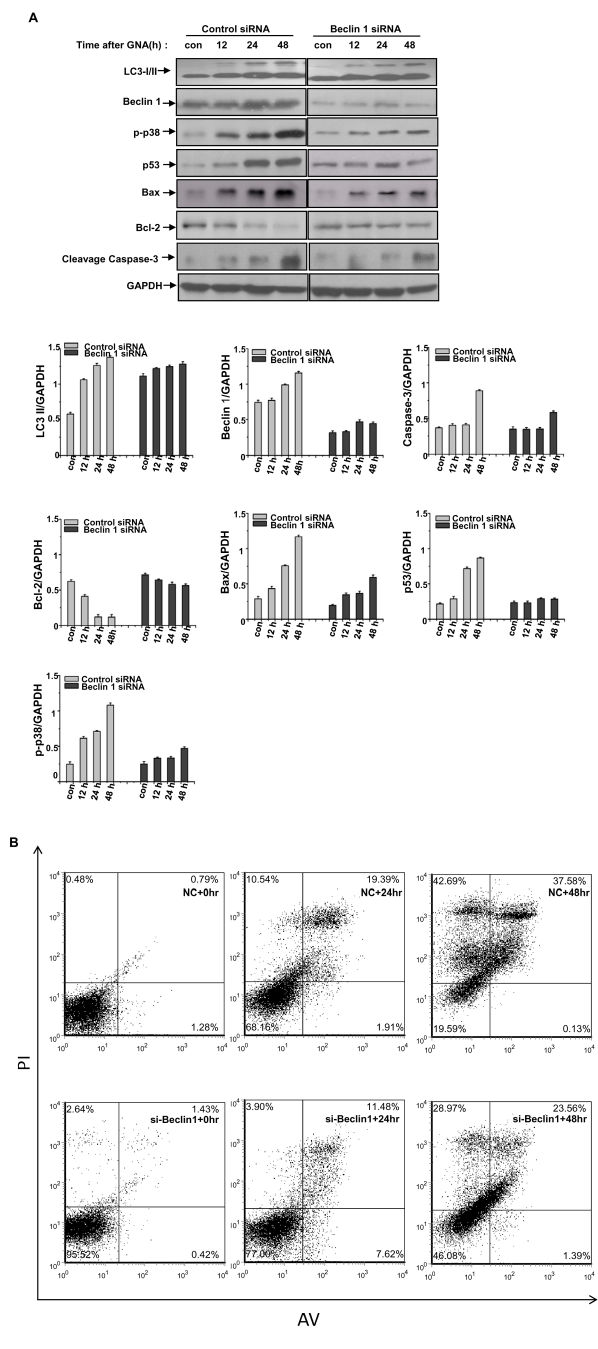
Figure 6. GNA induces apoptosis-related changes in protein levels. A, A549 cells were transfected with siRNAs against Beclin 1 or negative control. The cells were then treated with 3 m M GNA for the indicated periods of time. The relative protein level was analyzed by western blotting. GAPDH protein was used as the loading control. The bar graph shows the band intensities of indicated protein relative to those of GAPDH. Mean 6 SEM, n=3, *means p , 0.05, ** p , 0.01, one- way ANOVA. B, A549 cells were transfected with siRNAs against Beclin 1 or negative control. The cells were then treated with 3 m M GNA for the indicated periods of time, and the cells were stained with annexin V/ propidium iodide and subjected to flow cytometry analysis. The percentage in the upper left quadrant indicates the proportion of cells labeled with propidium iodide (dead cells), whereas the percentage in the upper right quadrant indicates the population of cells labeled by both annexin V and propidium iodide (late apoptotic and dead cells). doi:10.1371/journal.pone.0083604.g006 PLOS ONE |